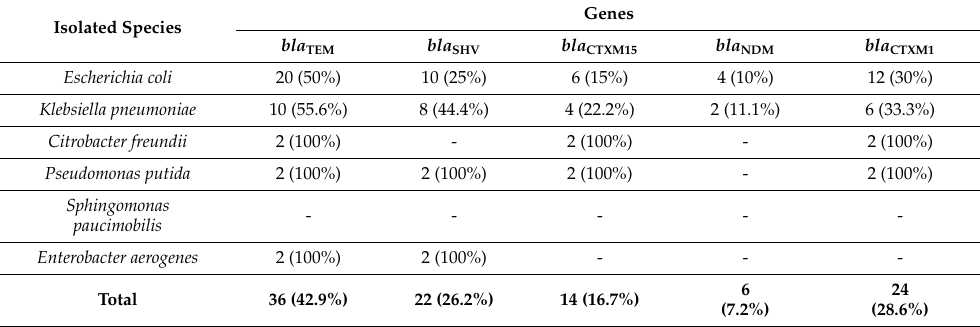
Table 9. Percentages of resistance genes detected from bacterial species isolated from